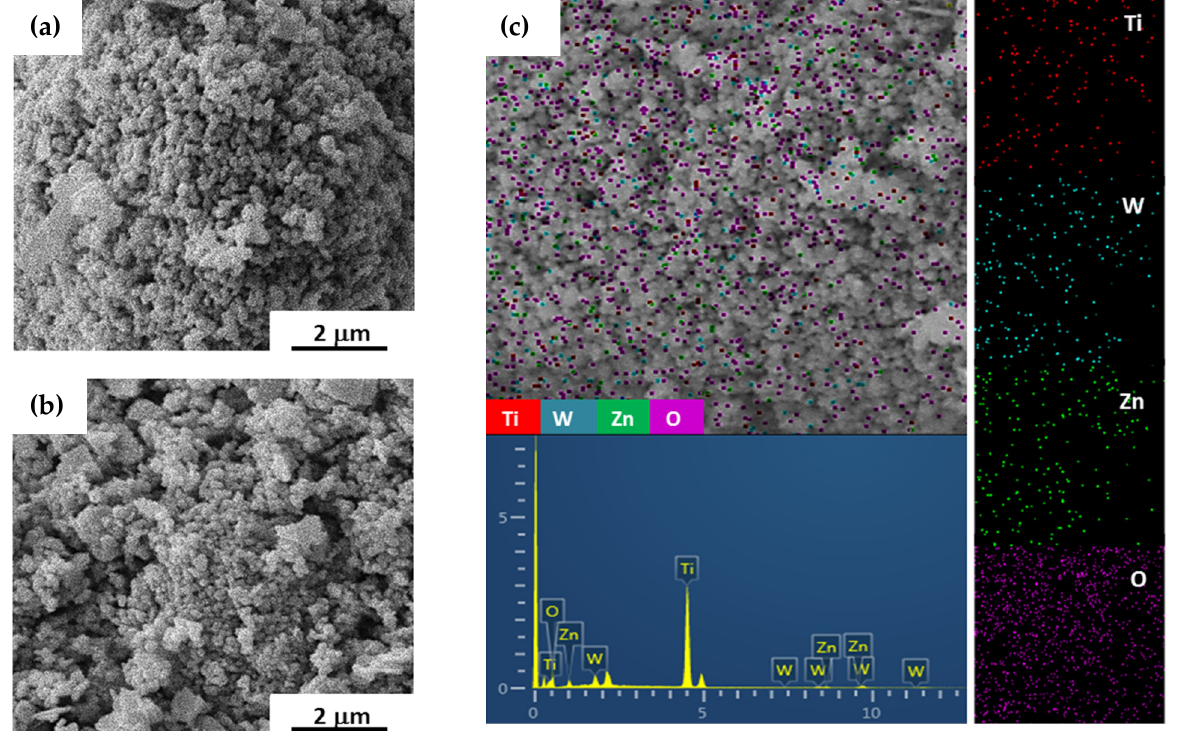
Figure 3. SEM micrographs of ( a ) TW − Zn 2 and ( b ) TW − Zn 4 MOHN after the sintering process; and ( c ) EDS elemental composition and mapping of sintered TW − Zn samples, with indication of titanium (Ti), tungsten (W), zinc (Zn), and oxygen (O) elements.